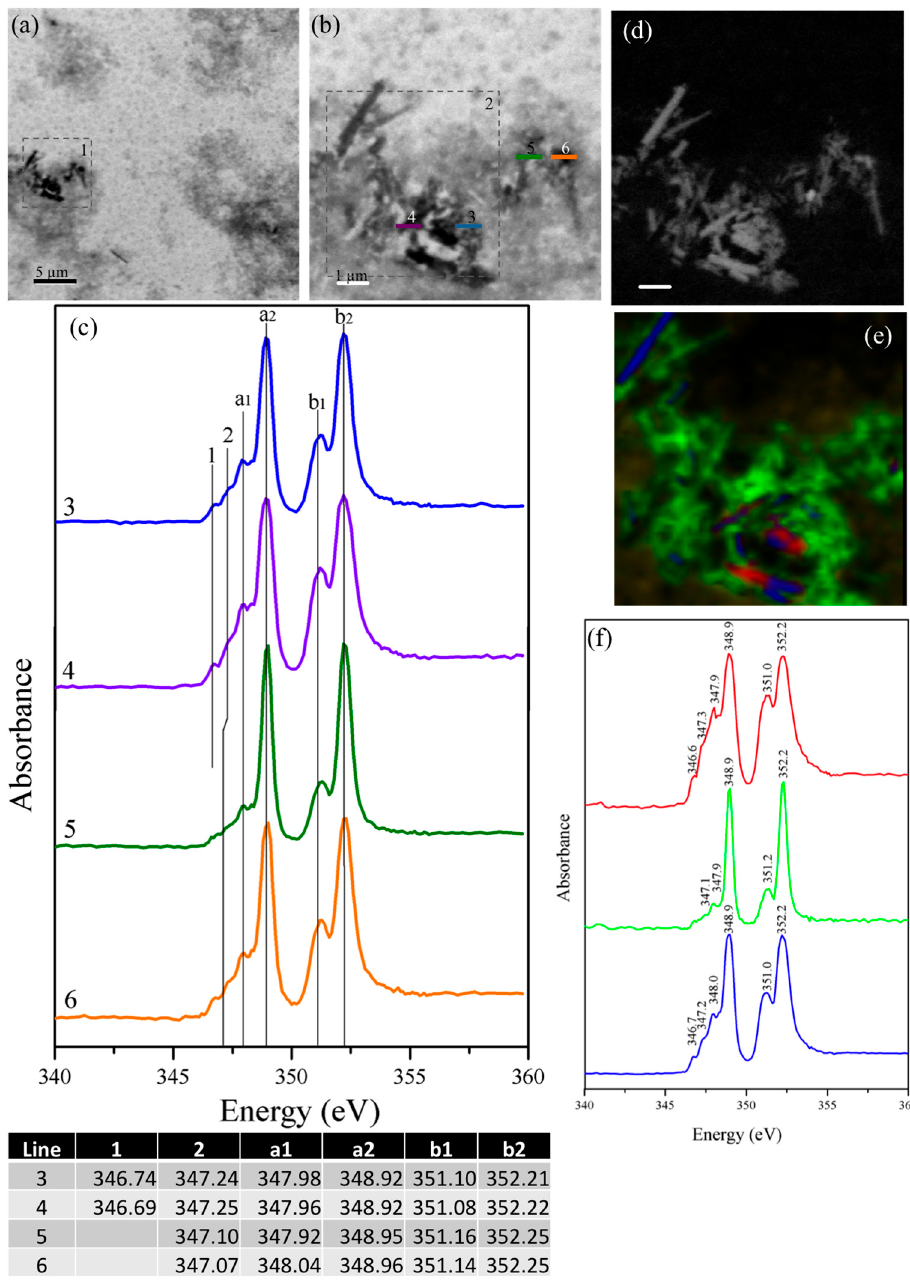
Figure 9. ( a ) Image taken at the calcium L II,III edge of the mix of the orthorhombic C 3 A and gypsum sample at a ratio of 1.9; ( b ) magnification of area 1 in ( a ); ( c ) NEXAFS spectra of line scans 3 and 4 indicated in ( b ); ( d ) image maps of calcium in the same area as ( b ), where the brighter areas are related to higher concentration of calcium; ( e ) RGB composite map of region 2 in Figure 9b; and ( f ) NEXAFS spectra of the red, green and blue regions observed in ( e ).